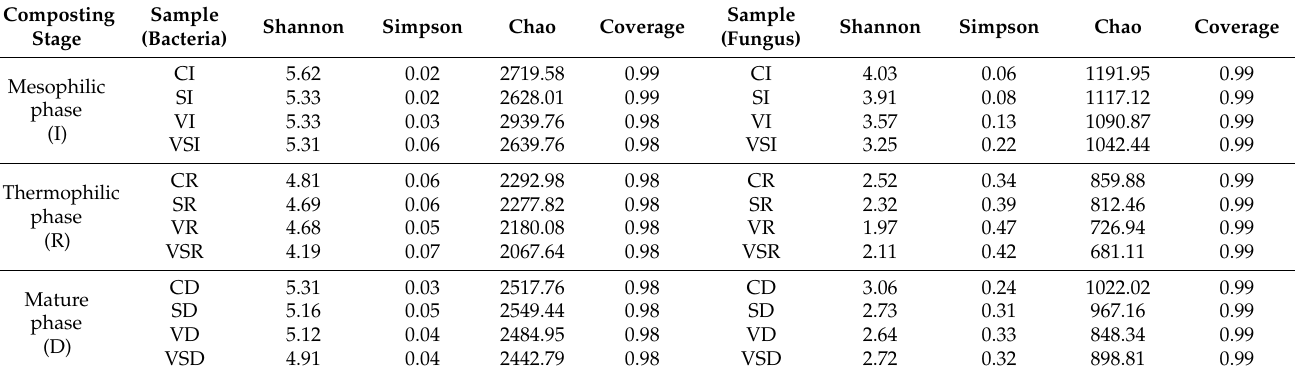
Table 2. Community diversity index of bacteria and fungus during different phases of composting.